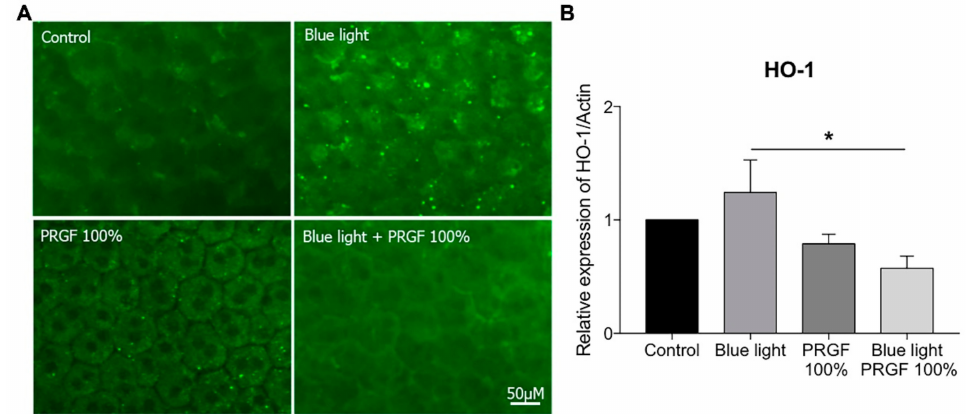
Figure 10. ( A ) RPE immunocytochemistry for HO-1 (green) ( n = 4), results showed that blue light increased HO-1 expression but PRGF 100% reduced it; ( B ) expression of HO-1 is increased by blue light, PRGF 100% significantly reduced its expression when combined with blue light. Statistical analysis: One-way ANOVA, Tukey multiple comparison test, and * p < 0.05. Scale = 50 µ